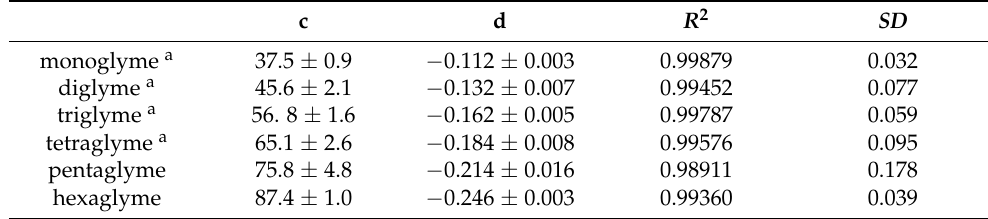
Table 9. The parameters of Equation (9). c d R 2 monoglyme